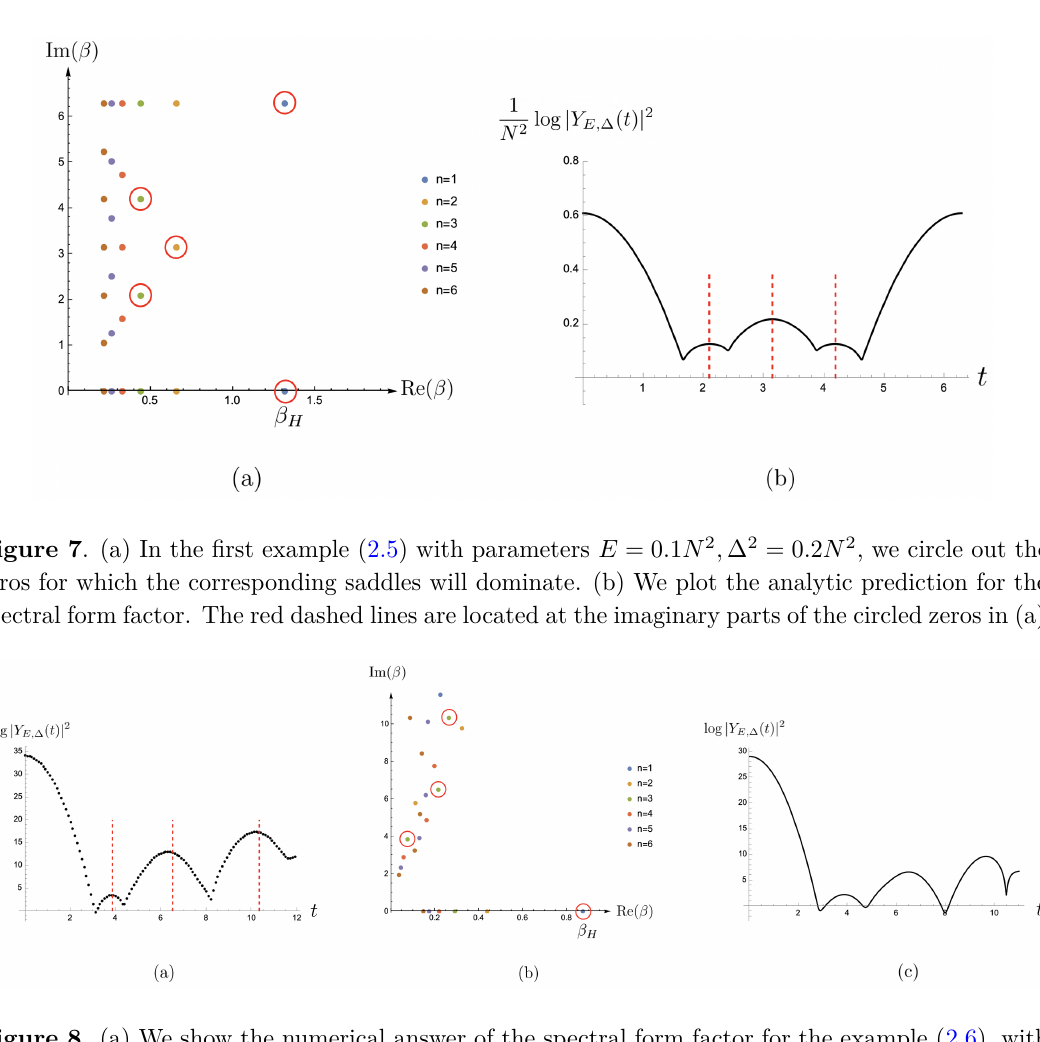
Figure 8 . (a) We show the numerical answer of the spectral form factor for the example (2.6), with E = 15 , ∆ 2 = 15 / 4 . (b) We circle out the zeros which correspond to the location of the peaks in (a). Their locations are represented by the red dashed lines in (a). We see that they correspond to n ≤ 3 . We are not seeing the contributions from some zeros with n > 3 in the numerics. We